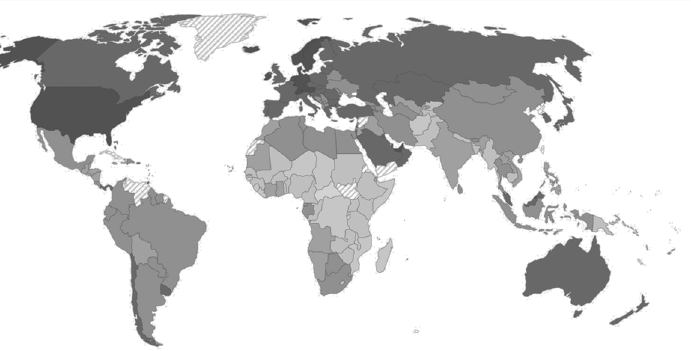
Figure 3. GDP per capita. Source: Our World in Data (2020). Countries with darker colors have higher GDP per capita.